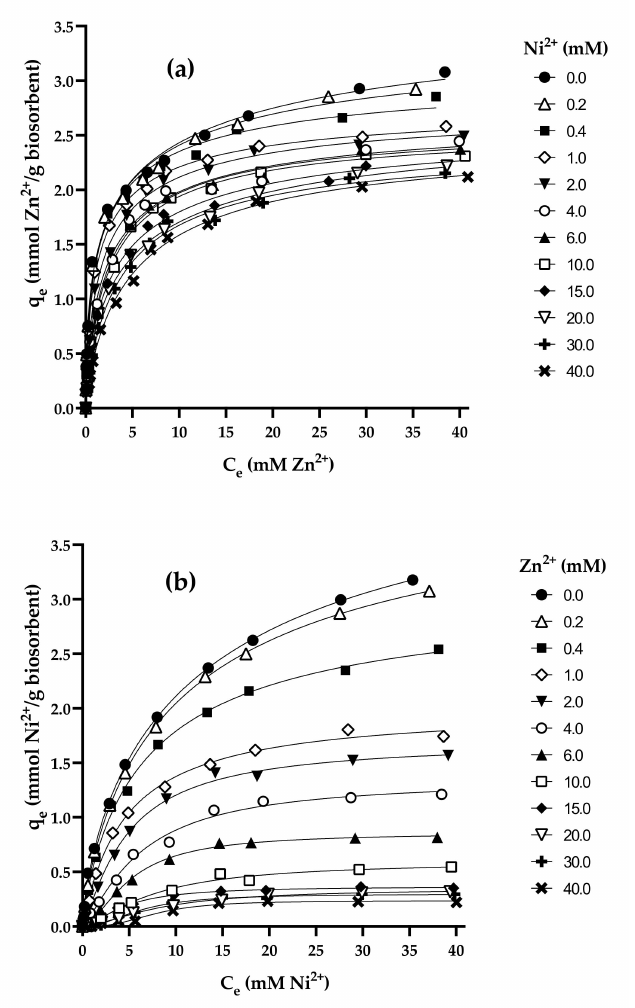
Figure 3. ( a ) Biosorption isotherms of Zn 2+ in the presence of increasing Ni 2+ concentrations; ( b ) biosorption isotherms of Ni 2+ in the presence of increasing Zn 2+ concentrations. Conditions: CS concentration = 1 g/L; temperature = 25 ◦ C; solution pH = 6.0. —: The modified Sips isotherm model